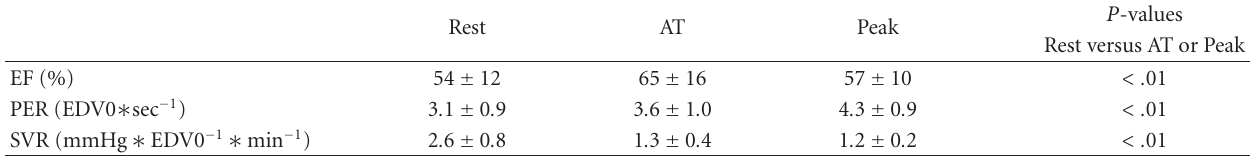
P -values Rest versus AT or Peak < . 01